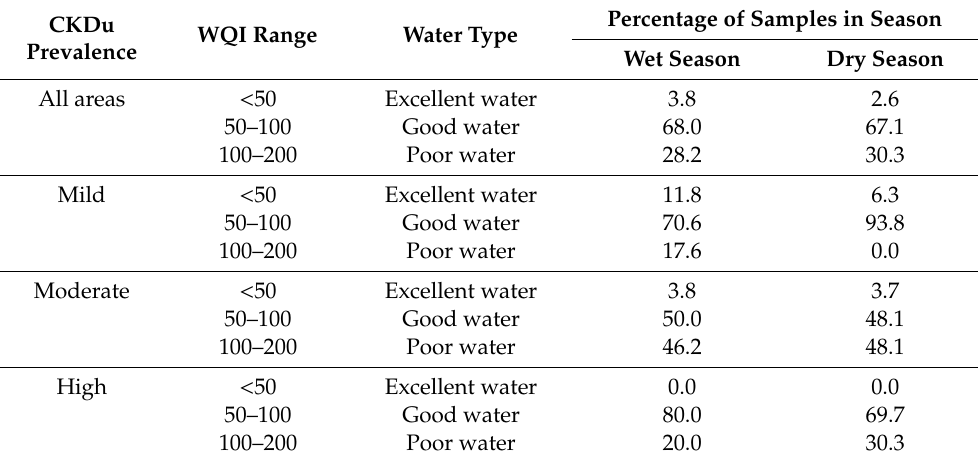
Figure 7. Water Quality Index (WQI) map of groundwater in the study area in the wet season ( a ) and dry season ( b ). Table 2. Water quality index (WQI) range and percentage of di ff erent water